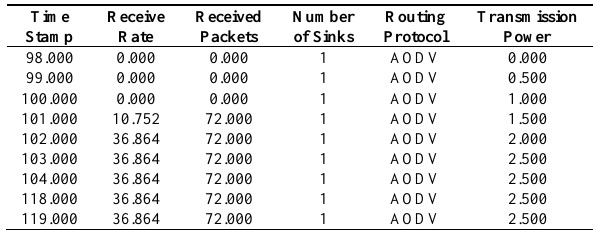
Table 3. Received Packets according to time stamp, rate of reception, number of received packets and number of sinks (1 st , 2 nd , 3 rd and 4 th columns respectively).